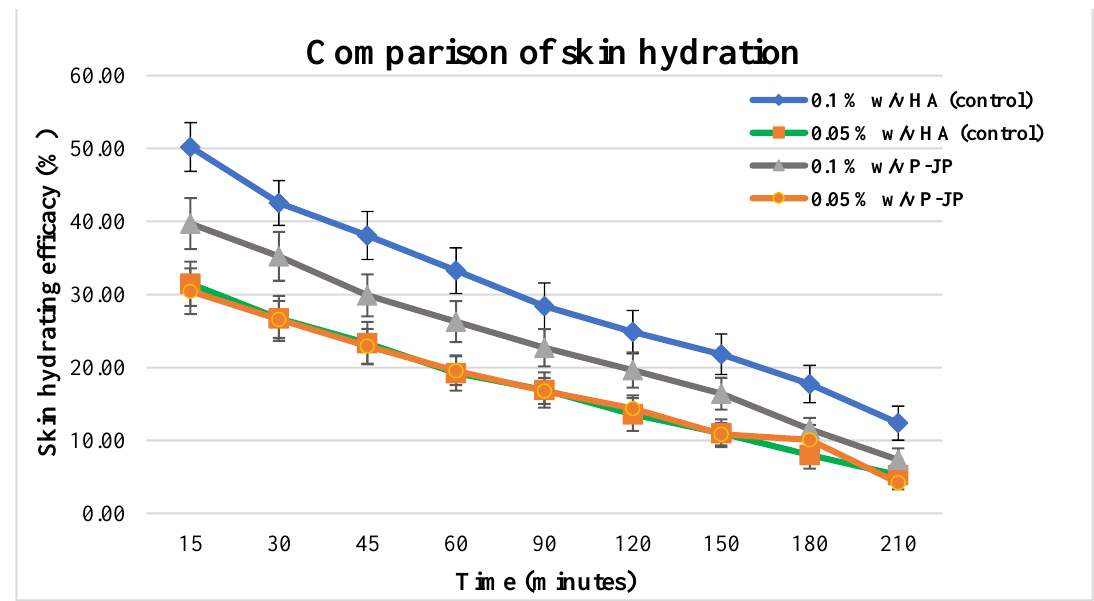
Figure 5. Skin hydrating efficacy of 0.05 and 0.1% w / v of the purified Japanese pumpkin polysaccharides (P-JP) in comparison with 0.05 and 0.1% w / v of hyaluronic acid (HA) evaluated for skin hydration from 0 – 210 min.